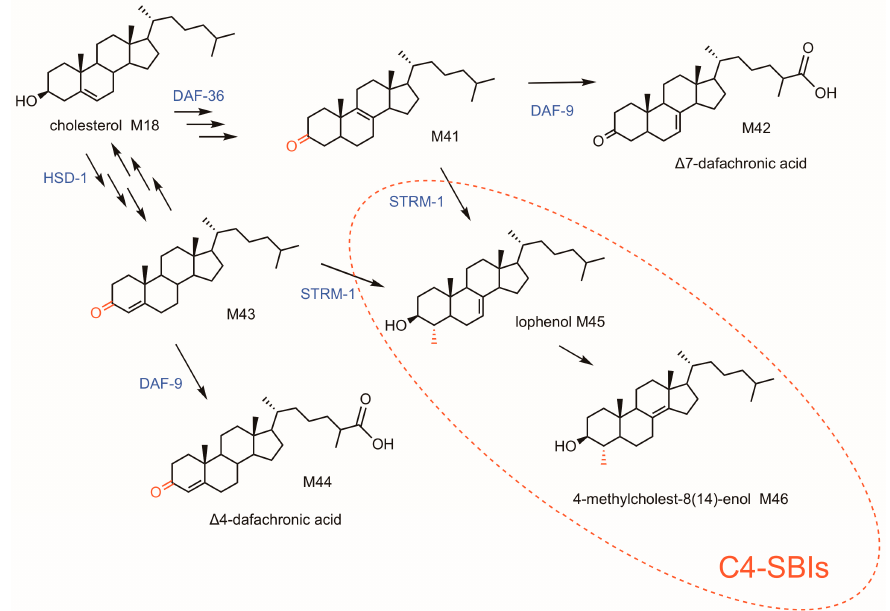
Figure 3. Dafachronic acid synthesis in Caenorhabditis elegans . Sterol nomenclature is given in Table 1. C4-demethylation in eukaryotes: HSD-1, 3-hydroxysteroid dehydrogenase/ ∆ 5/ ∆ 4 isomerase (HSD-1); STRM-1, Sterol 4-C-methyltransferase; DAF-9, steroid cytochrome P450 hydroxylase; DAF-36, cholesterol 7-desaturase. Each arrow represents an enzymatic